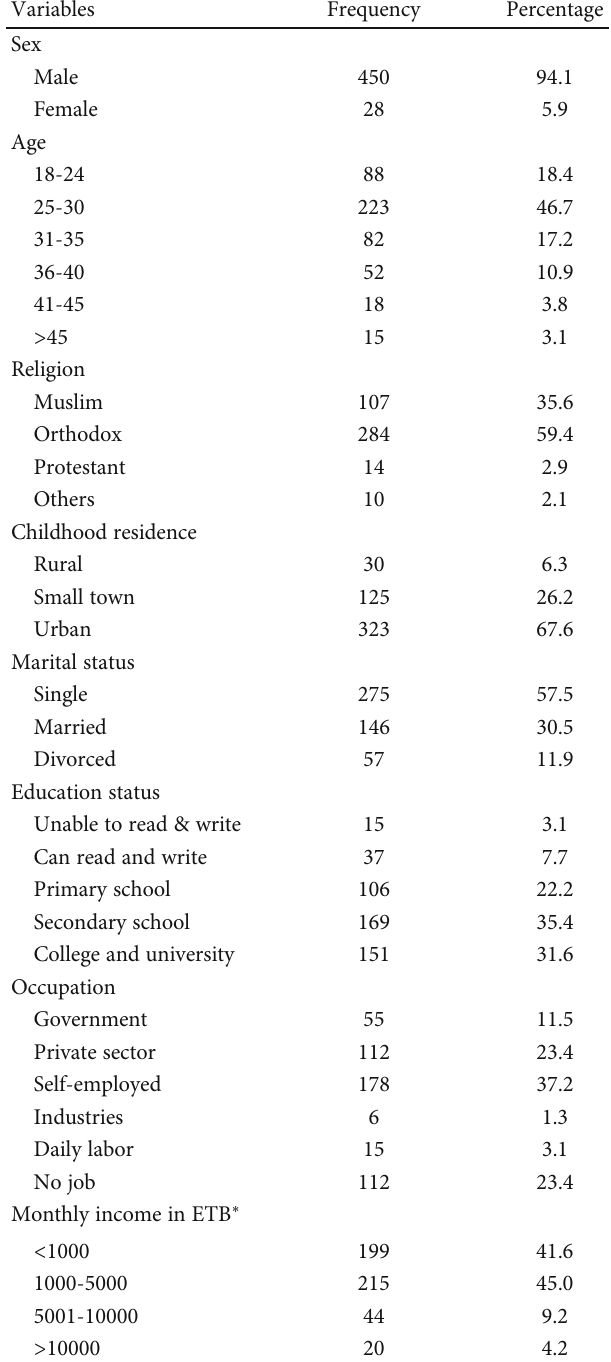
Table 1: Sociodemographic characteristics of khat chewer in the Amhara region, 2019 ( N = 478